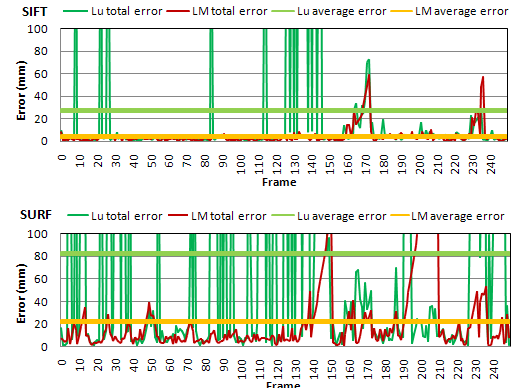
Figure 24. Accuracy of Lu and LM methods with SIFT (top) and SURF (bottom)